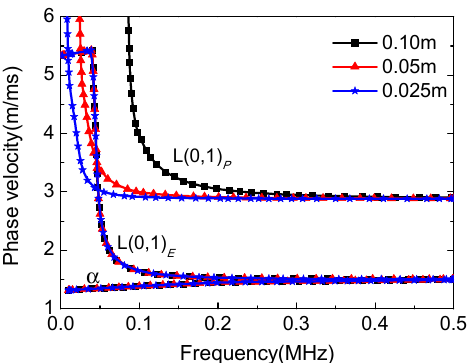
Figure 5. Dispersion curves of guided waves in water-filled pipe embedded in a finite porous medium of layer thickness d = 0.025, 0.05, 0.10 m. Porosity is β = 0.1. Black, red, and blue lines represent layer thicknesses d = 0.025, 0.05, and 0.10 m, respectively.